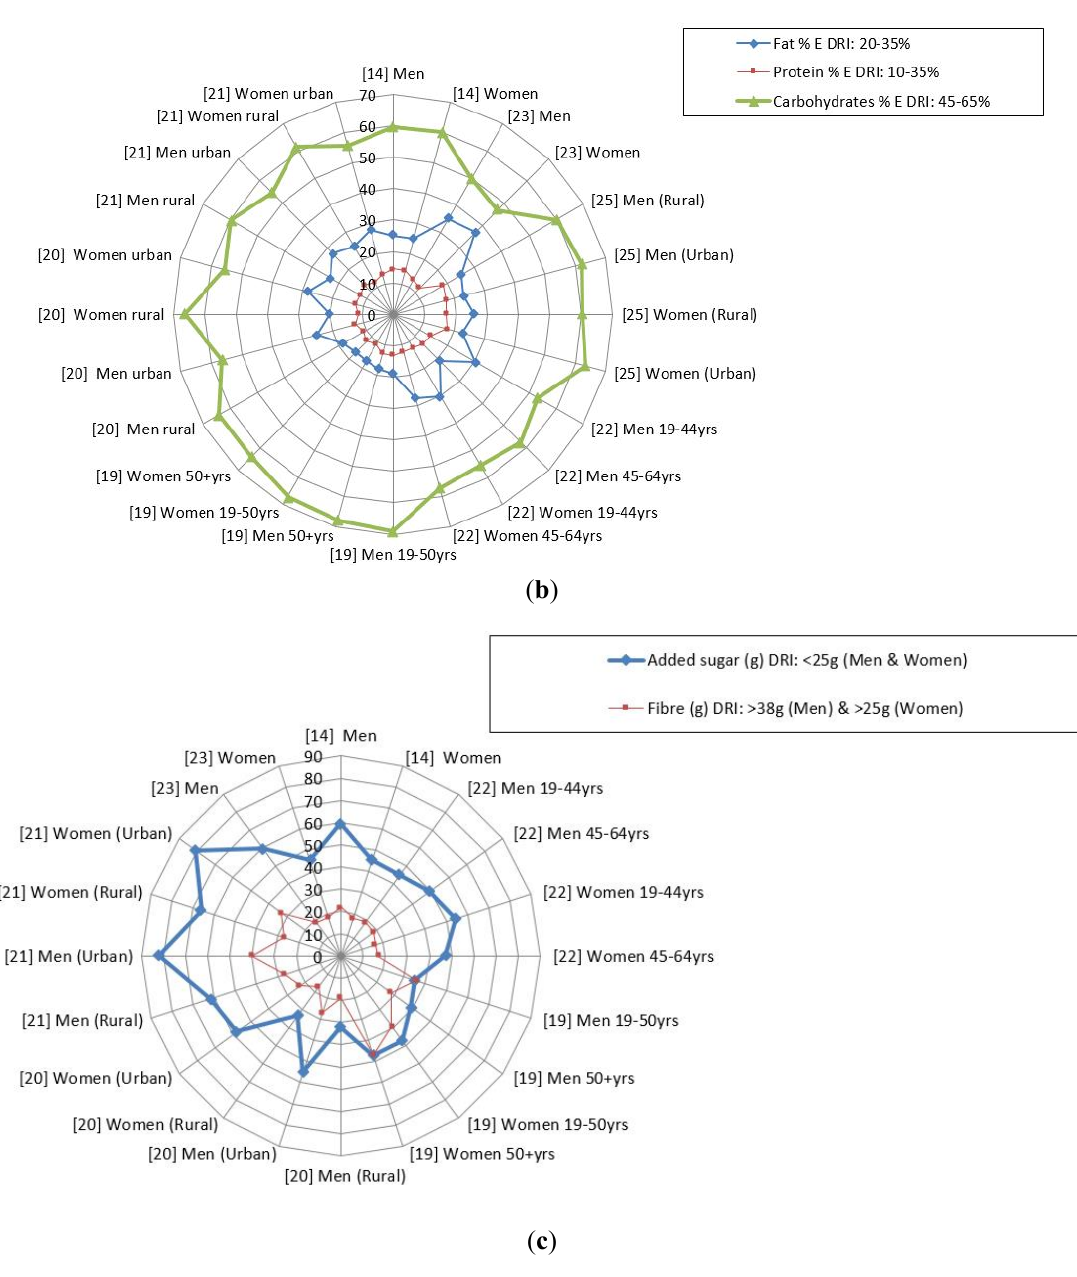
Figure 2. ( a ) Mean total energy intake (kilo Joules, kJ) consumed by South African